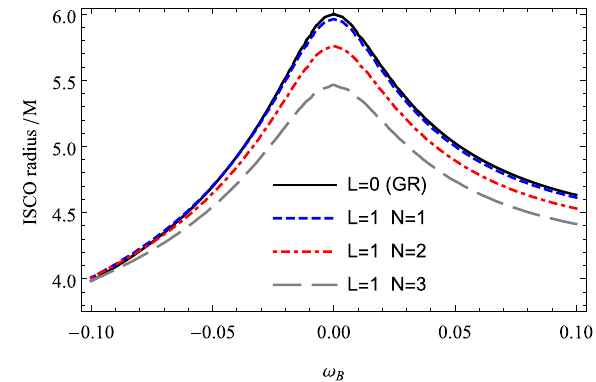
Fig. 8 Dependence of the ISCO radius of the charged particle on the magnetic parameter for various values of the conformal and scale